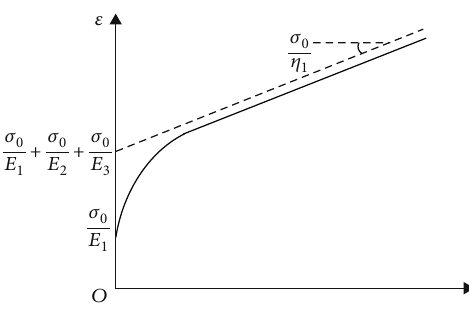
Figure 3: Generalized Burgers creep